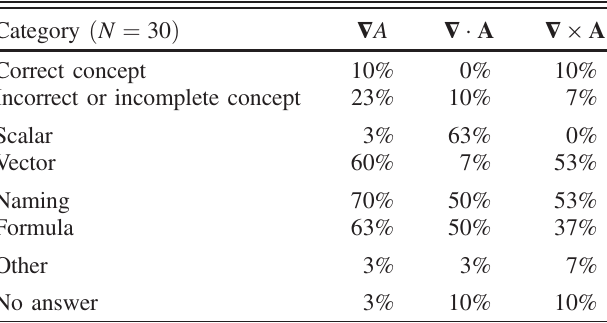
TABLE I. Categorization of students ’ interpretation of the expressions ∇ A , ∇ · A , and ∇ × A